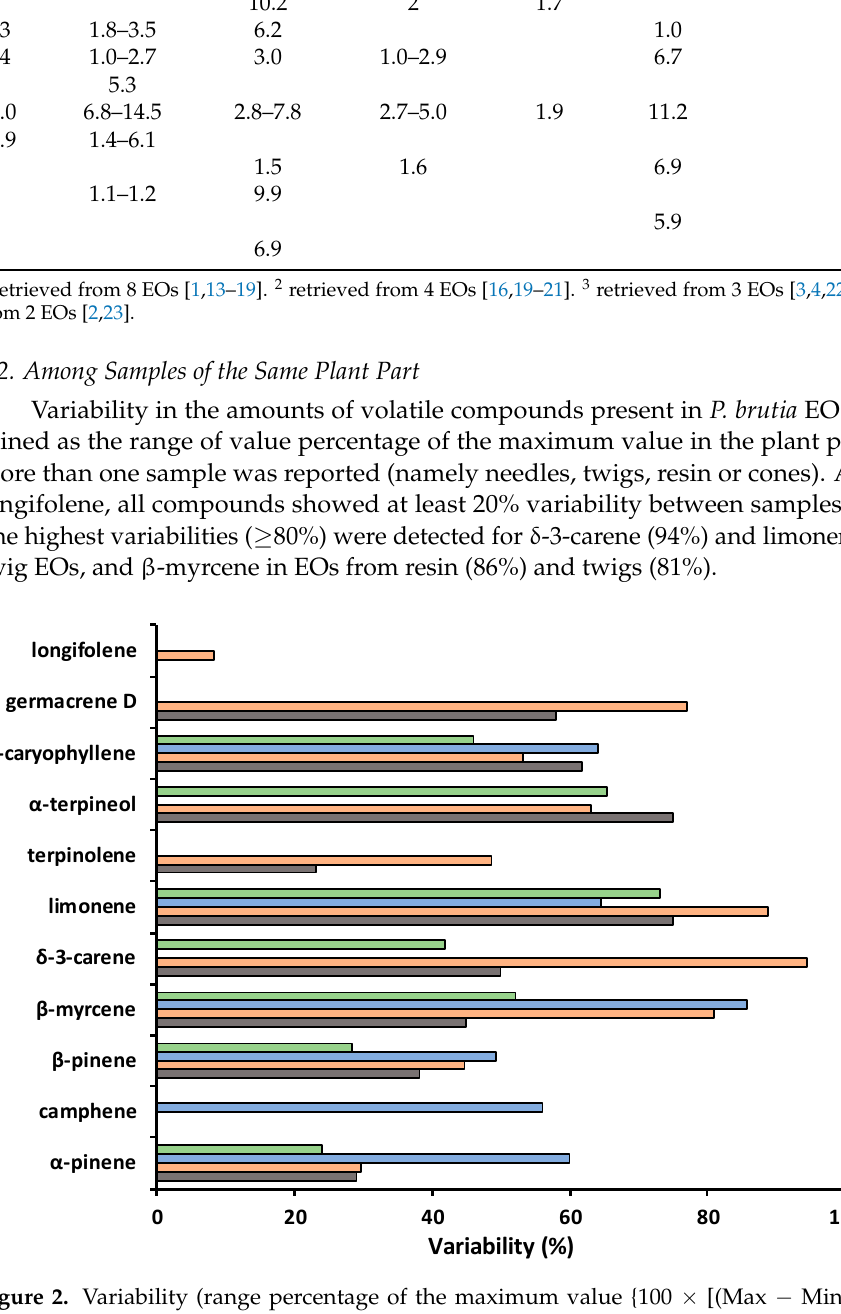
Figure 2. Variability (range percentage of the maximum value {100 × [(Max − Min)/Max]}) of essential oil compounds in Pinus brutia needles (grey bars), twigs (orange bars), resin (blue bars) and cones (green bars).